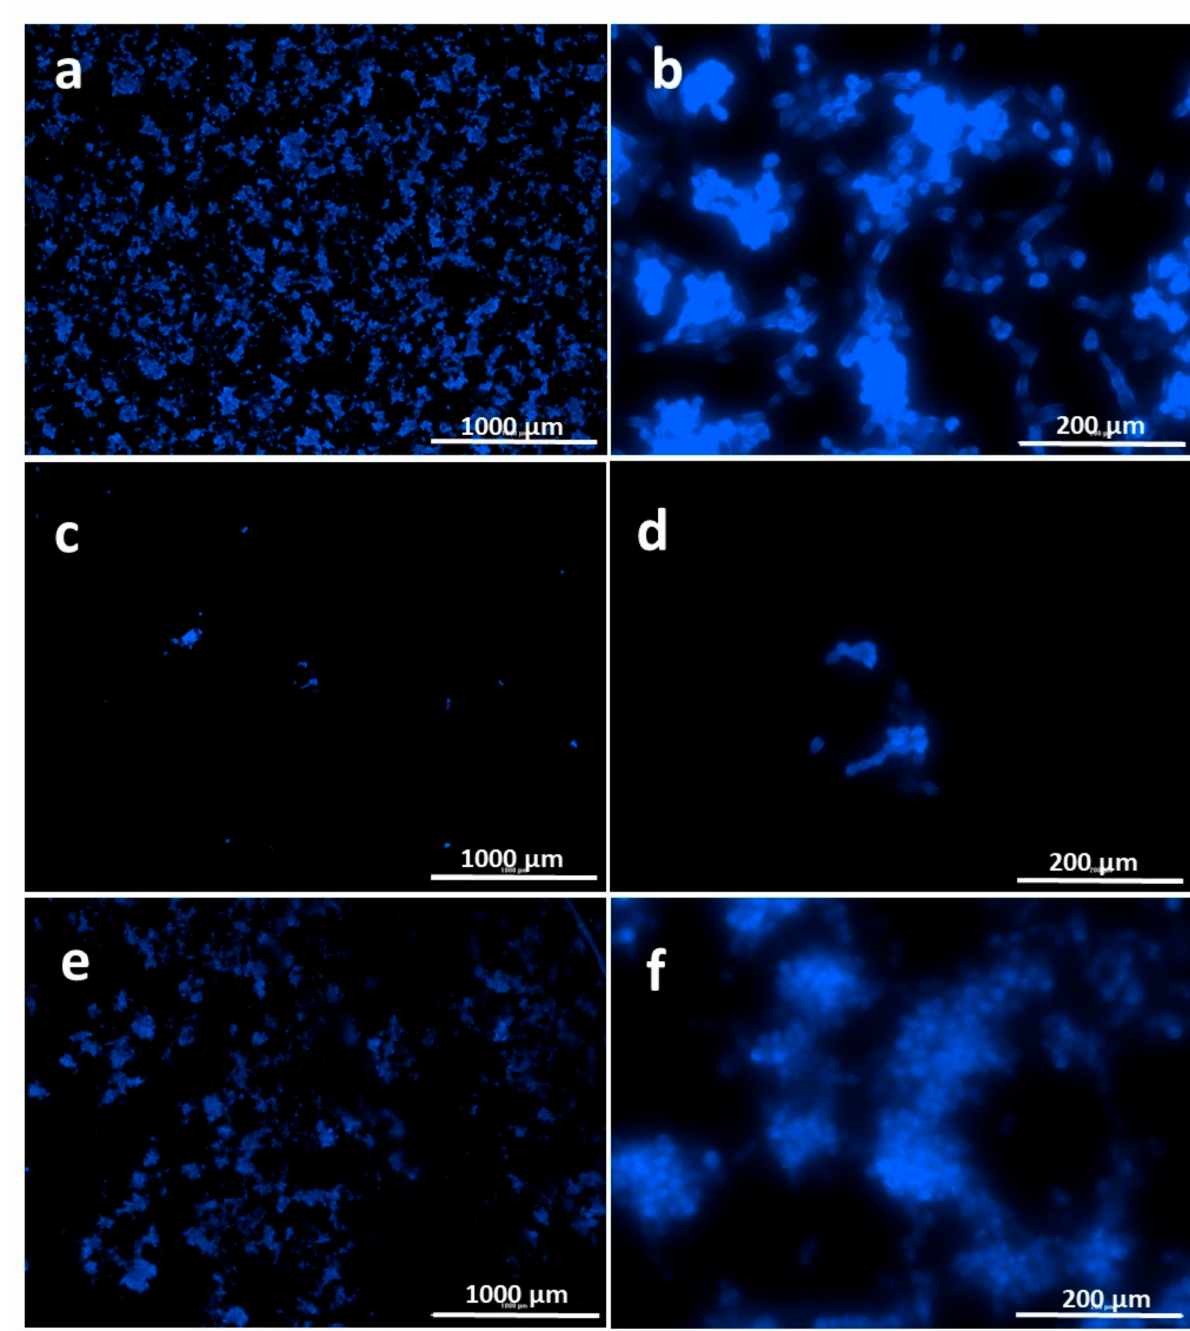
Figure 7. Cell attachment images of DAPI stained PCS-201-012 cells after being cultivated with electrosprayed surfaces with different magnifications, ( a , b ) hHL, ( c , d ) hHL/0.05RS, and ( e , f ) hHL/0.1RS for 24